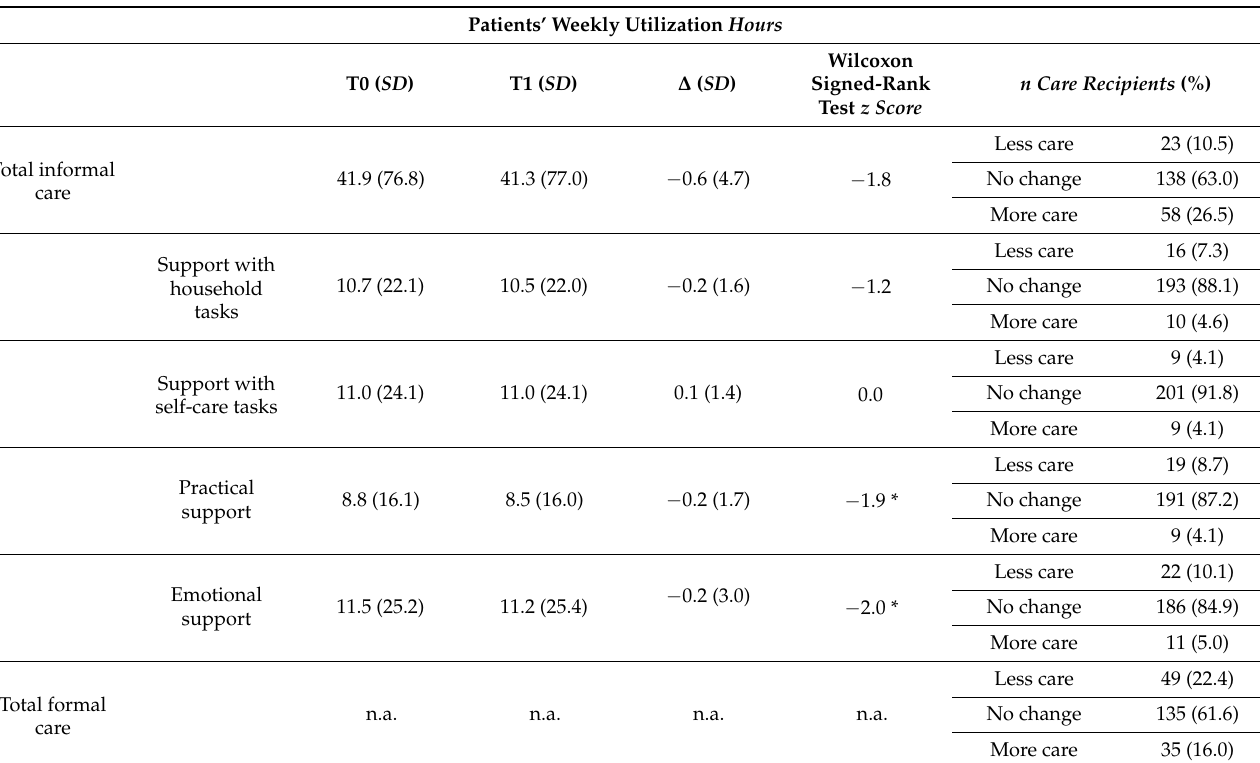
Table 2. Patients’ Informal and Formal Care Utilization at T0 and T1 ( n = 219).